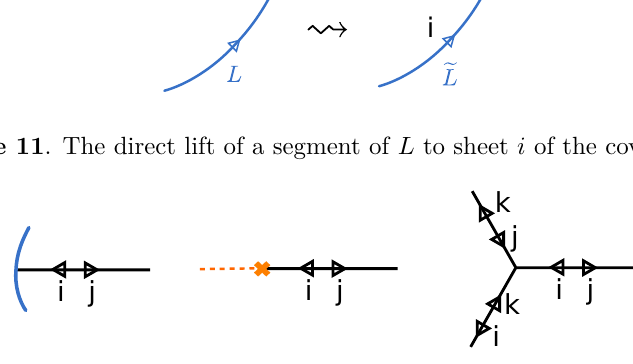
Figure 12 . Three ways in which an ij -segment of a web can end: on a link segment, a branch point, or a